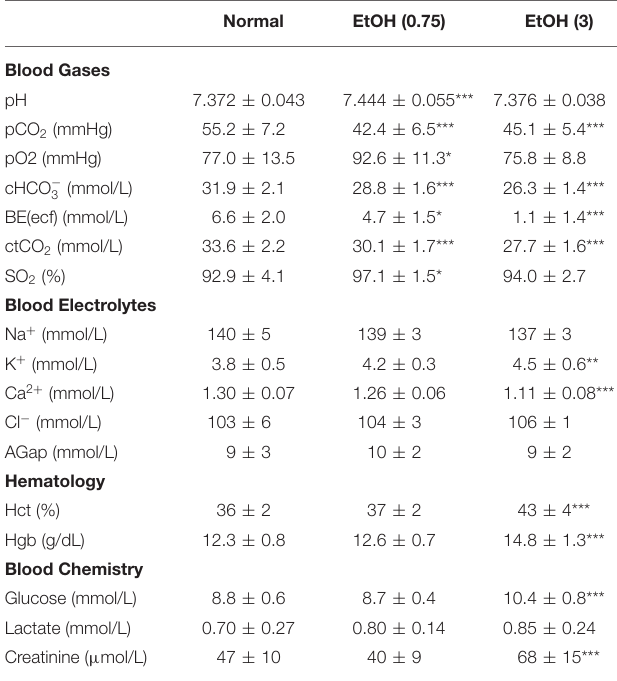
TABLE 2 | Physiological parameters in normal, EtOH (0.75 g/kg, i.p.), and EtOH (3 g/kg, i.p.)